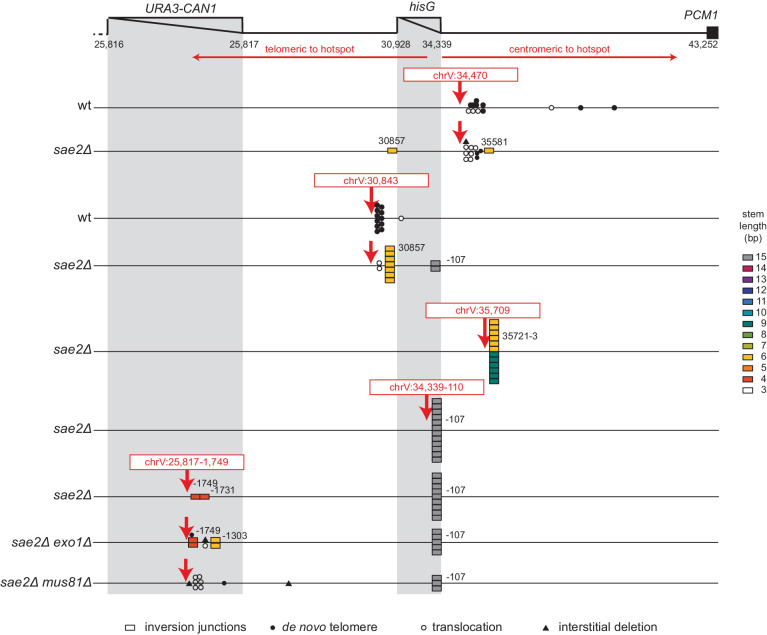
Analysis of GCRs generated by induction of site-specific DSBs.The position of CRISPR/Cas9 cleavage sites are indicated by red arrows. The sites at which various rearrangements were induced are indicated by different symbols: inversion junctions are shown as boxes, de novo telomere additions as filled circles, microhomology-mediated translocations as open circles, and microhomology-mediated interstitial deletions as filled triangles. The relevant genotype of the strains where the DSBs were induced is indicated on the left side.